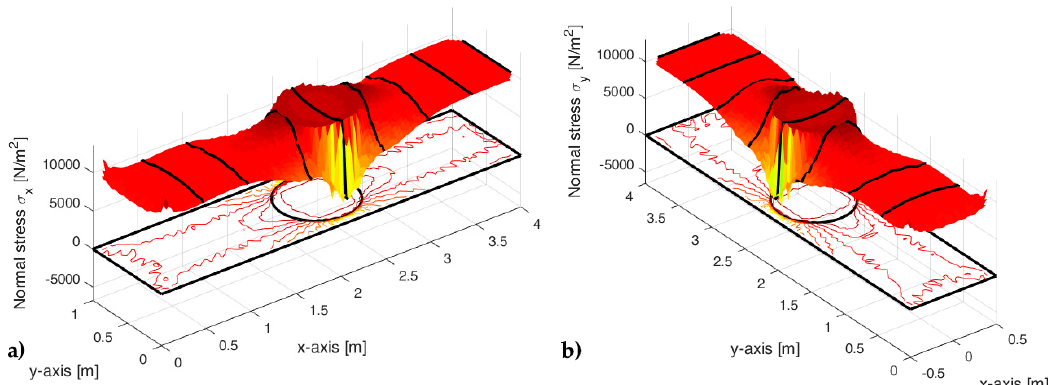
Figure 30. 3D plots and isolines of the axial stresses for: ( a ) The numerical results of the CM model and ( b ) the numerical results of the DECM model for n r = 1 and n c = 1.